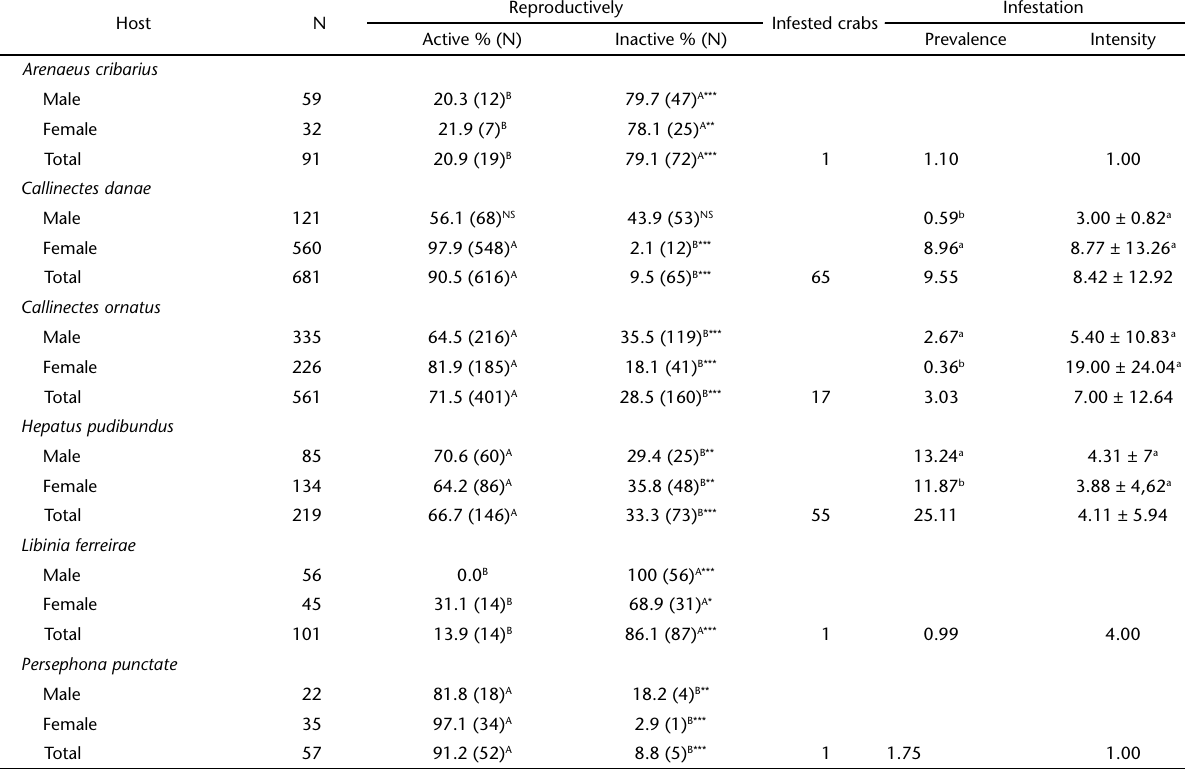
Table I. Brachyuran species infested by Octolasmis lowei . Total number of adults (N), proportion of actively reproducing and inactive male and female infested crabs, prevalence (%) and median infestation intensity (± SD = standard deviation) according to host species and sex for the three most abundant hosts. Same small letters in the same column indicate lack of significance between sexes for each of the host species (p >